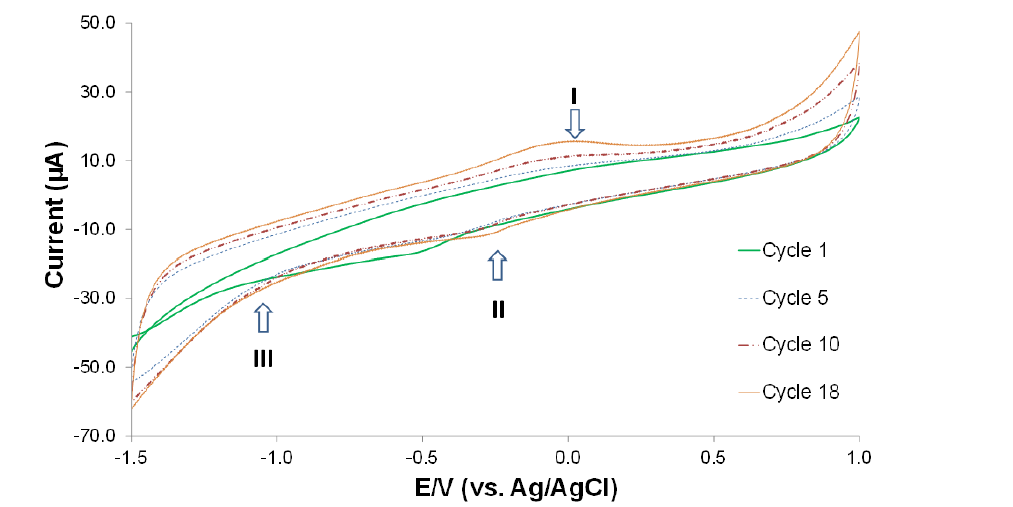
Figure 5. CV curve of graphene oxide electrodeposition on a GCE showing one anodic peak -I and two cathodic peaks -II and III.